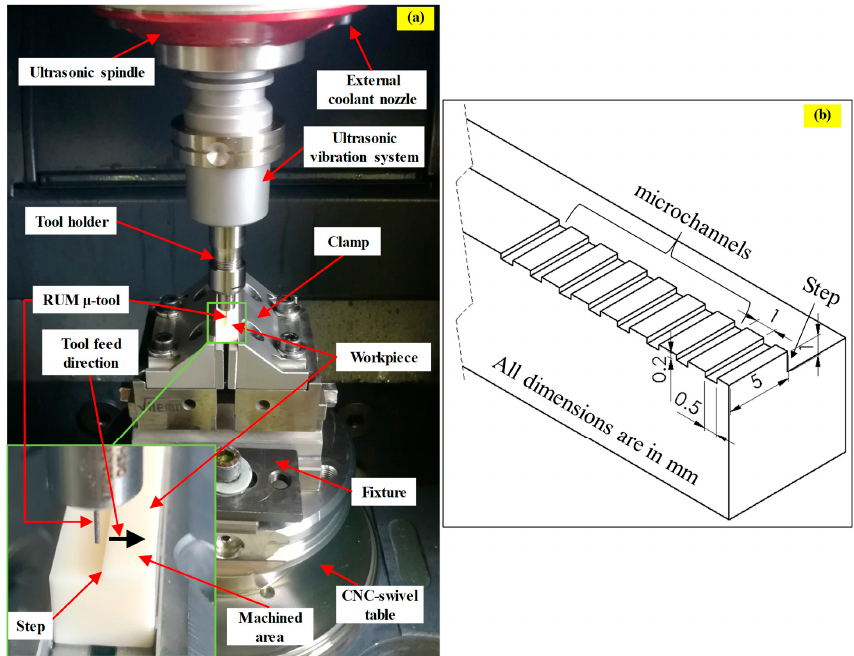
Figure 2. ( a ) RUM experimental set up; ( b ) 3D schematic of the microchannels.